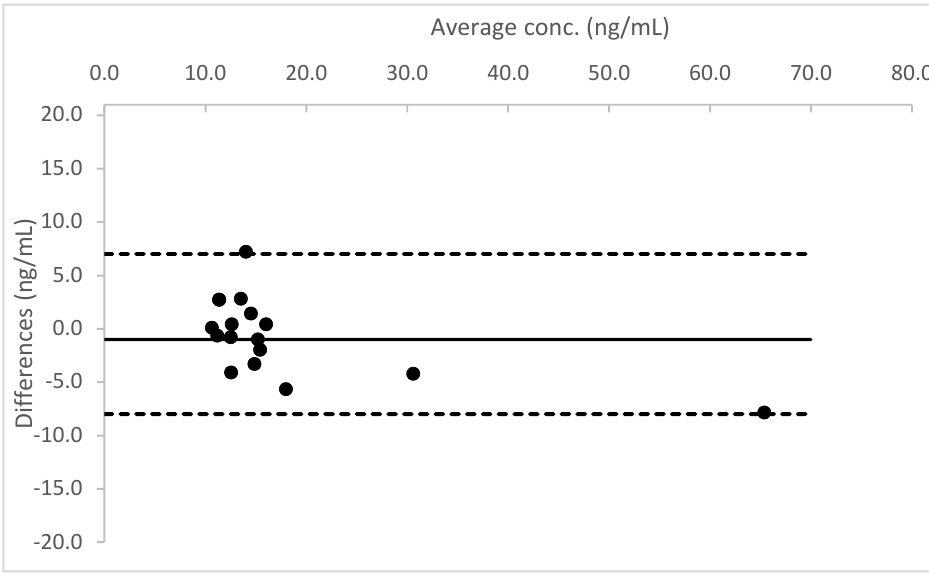
Figure 4. Bland – Altman plot for the results obtained from Whatman™ 903 card, in comparison to the data measured in liquid urine for THC.